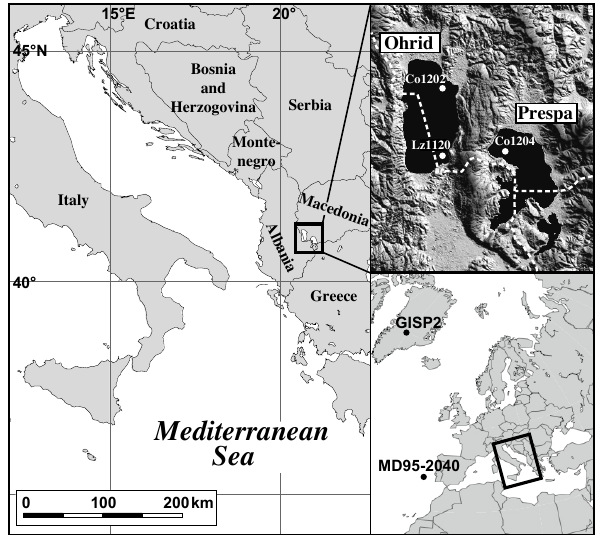
Fig. 1. Map of the northern Mediterranean region showing the loca- tion of lakes Ohrid and Prespa. White dots indicate coring locations Lz1120 and Co1202 in the southeastern and northeastern part of Lake Ohrid, and coring location Co1204 in the northwestern part of Lake Prespa. Dashed white line indicates the border between Albania, Macedonia and Greece. The insert at the right (bottom) shows the locations of the marine sediment core MD95-2040 from the western Iberian margin and the GISP2 ice core from